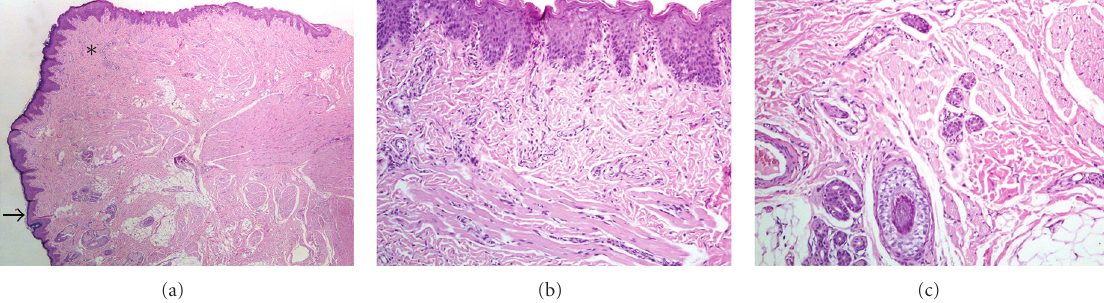
Figure 3: (a) The cephalic papule represented wide bundles of striated muscle covered by stratified squamous epithelium with surface parakeratosis. The arrow shows the transition towards normal skin displaying adnexal structures at the cephalic end of the specimen. The sign “ ∗ ” marks the area shown in higher magnification in (b) ( × 2, hematoxylin-eosin stain). (b) shows thin bundles of striated muscle extending superficially underneath the parakeratotic squamous epithelium covering the papule ( × 10, hematoxylin-eosin stain). (c) shows the striated muscle bundles at the edge of the lesion to extend towards the adjacent normal skin and to surround sweat gland ducts and a hair follicle ( × 10, hematoxylin-eosin stain).